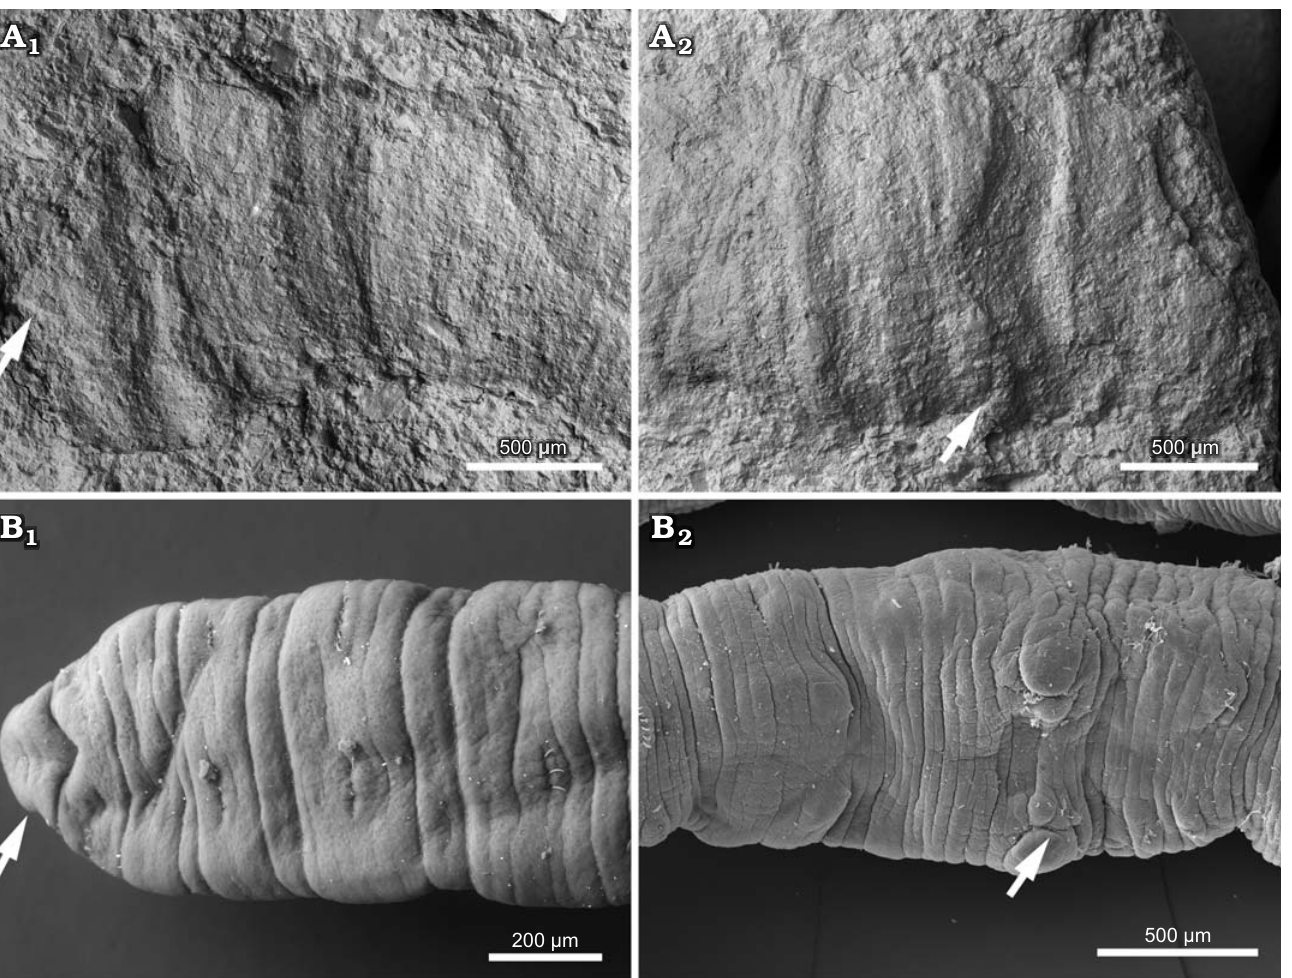
Fig. 3. Microdrile oligochaete PIN 5640/212 ( A ) from the Petropavlovka Formation, Olenekian (Lower Triassic), Petropavlovka III section, Russia and extant Tubifex tubifex (Müller, 1774) ( B ) from the Khripan’ River, Moscow region, Russia, SEM. A . Anterior part with possible prostomium (arrowed) (A 1 ). Posterior part of specimen with W-shaped depression (arrowed) and possible genital region (A 2 ). B . Anterior part showing prostomium (arrowed) and arrangement of chaetae (B 1 ). Genital region depicting male pores (arrowed) (B 2